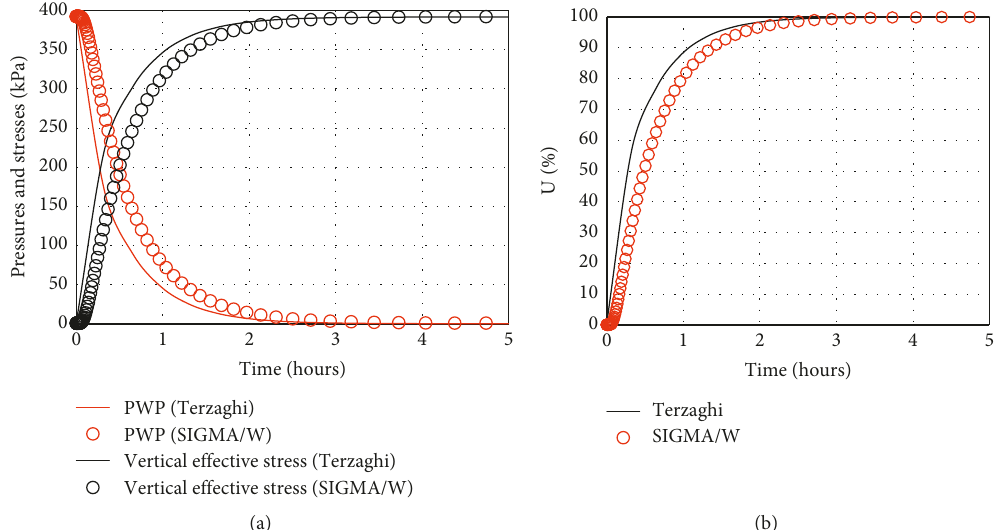
Figure 19: Degrees of consolidation, calculated by the analytical solution (equation (A.1)) and estimated by the numerical modeling with